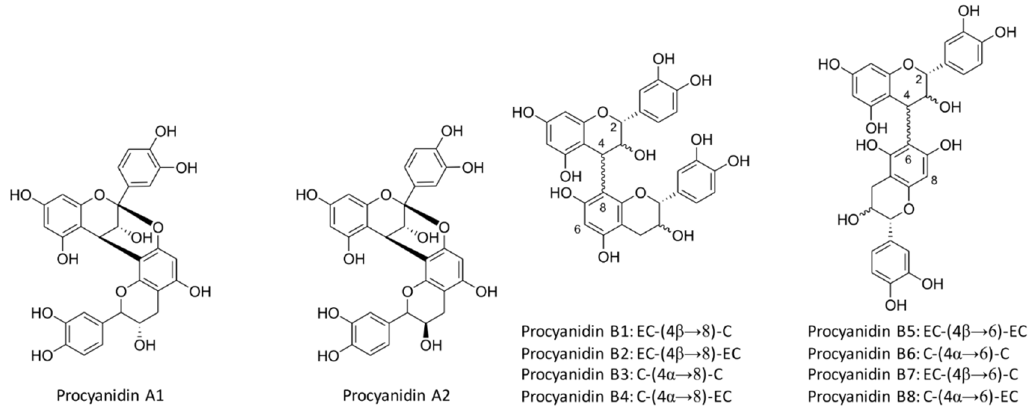
Figure 3. Cont. Figure 3. Structure of Type-A and Type-B proanthocyanidins. Figure 3. Structure of Type-A and Type-B